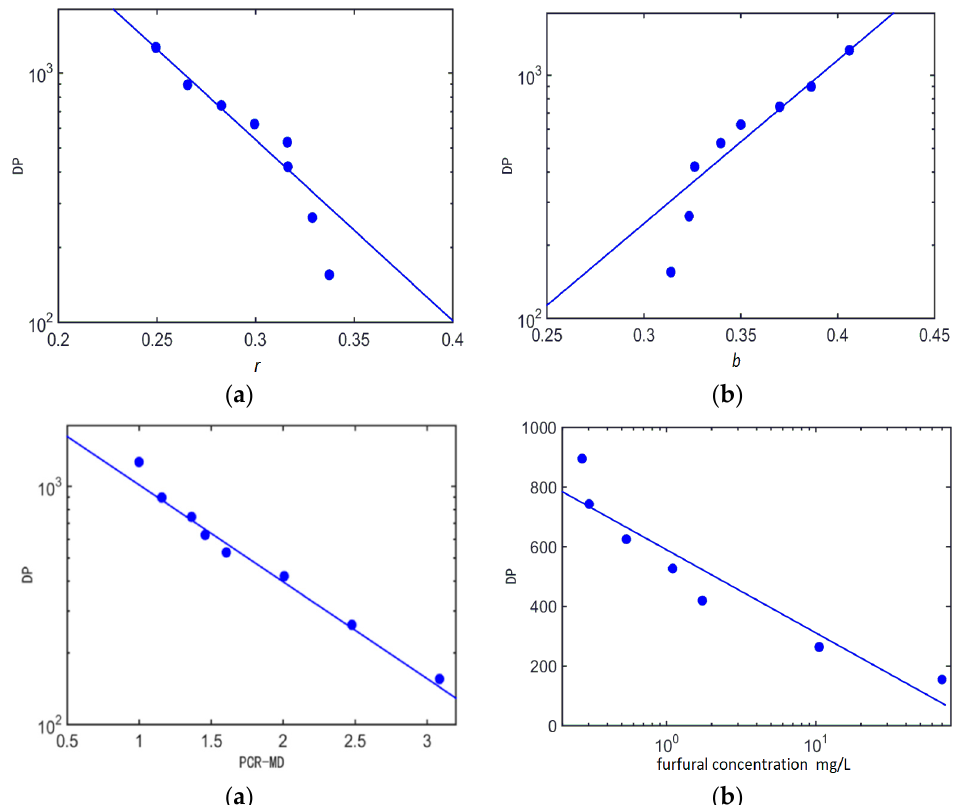
Figure 6. ( a ) Fitting of DP and r; ( b ) Fitting of DP and b; ( c ) Fitting of DP and D; ( d ) Fitting of DP and furfural concentration. Table 1. Comparison of fitting parameters ( k 1 , k 2 , k 3 , and k 4 ), goodness of fit (R 2 ), and mean square error (RMSE)